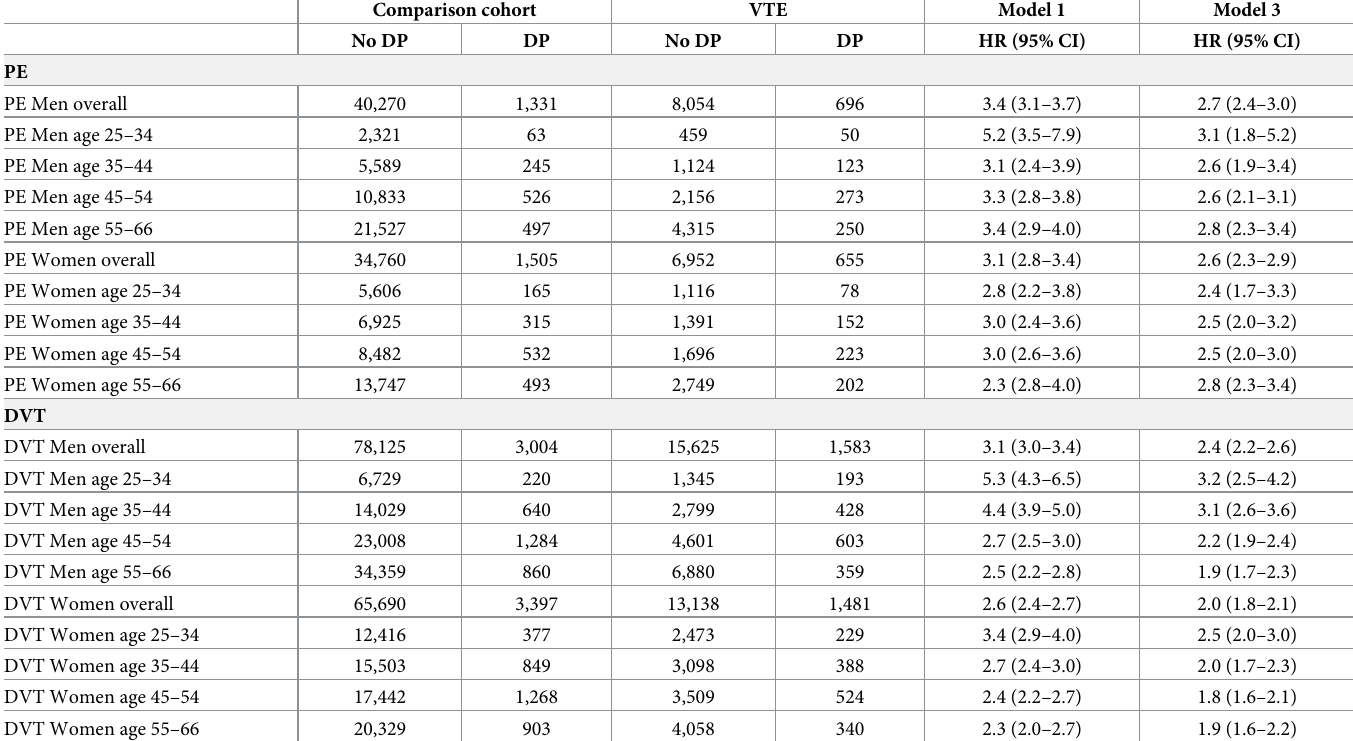
Table 5. Subgroup analysis by age and sex with IRs and HRs with 95% CIs of receipt of a work-related DP among persons with and without VTE (PE versus DVT).